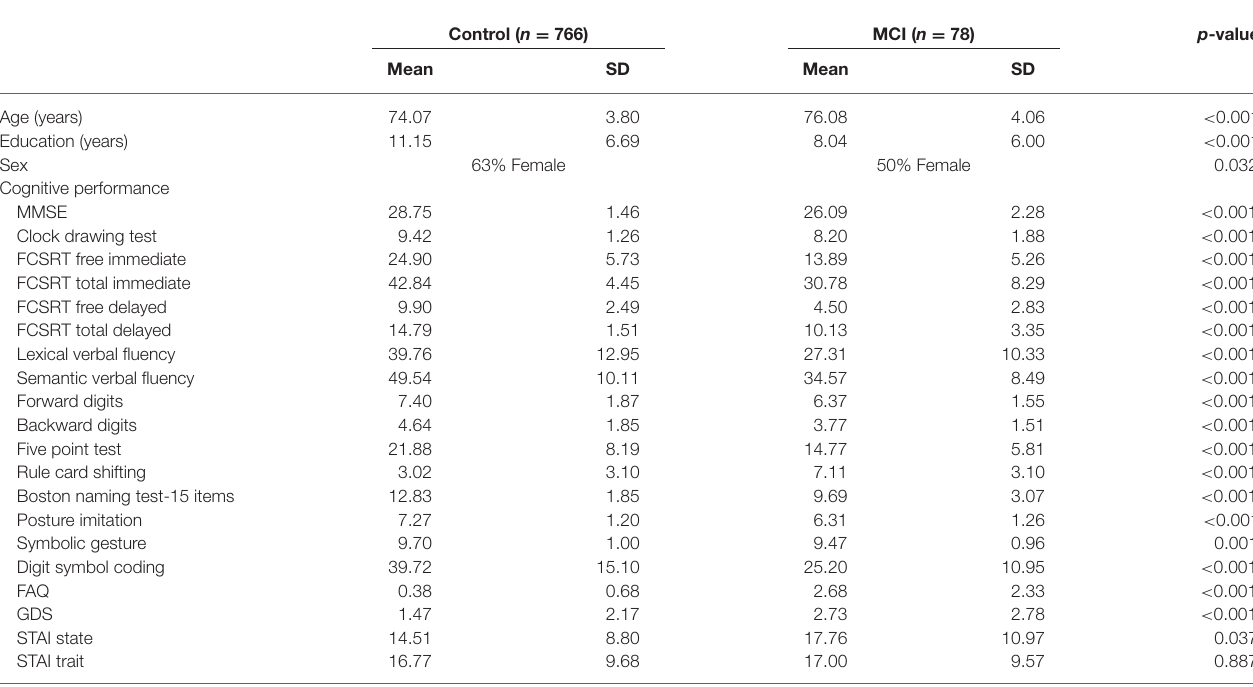
TABLE 1 | Descriptive analysis and mean differences between control and MCI